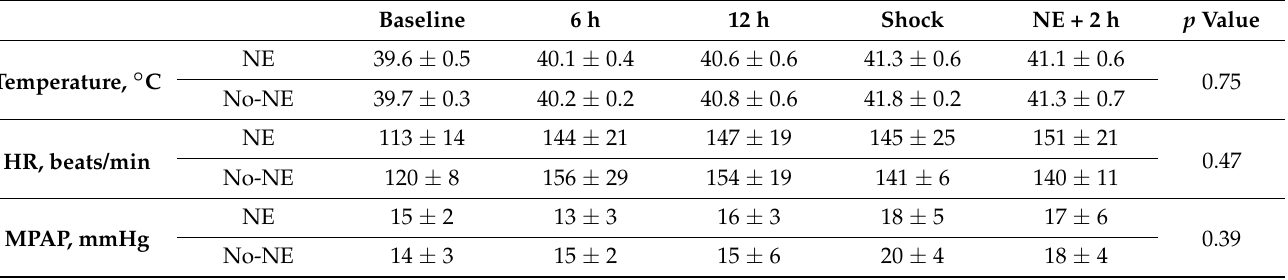
Table 1. Hemodynamic and respiratory variables in the two groups at different study time-points. The p value corresponds to the mixed-effects model analysis. HR, heart rate; MPAP, mean pulmonary artery pressure; PAOP, pulmonary artery occlusive pressure; TPC, thoraco-pulmonary compliance; NE, norepinephrine. Data are given as mean ±